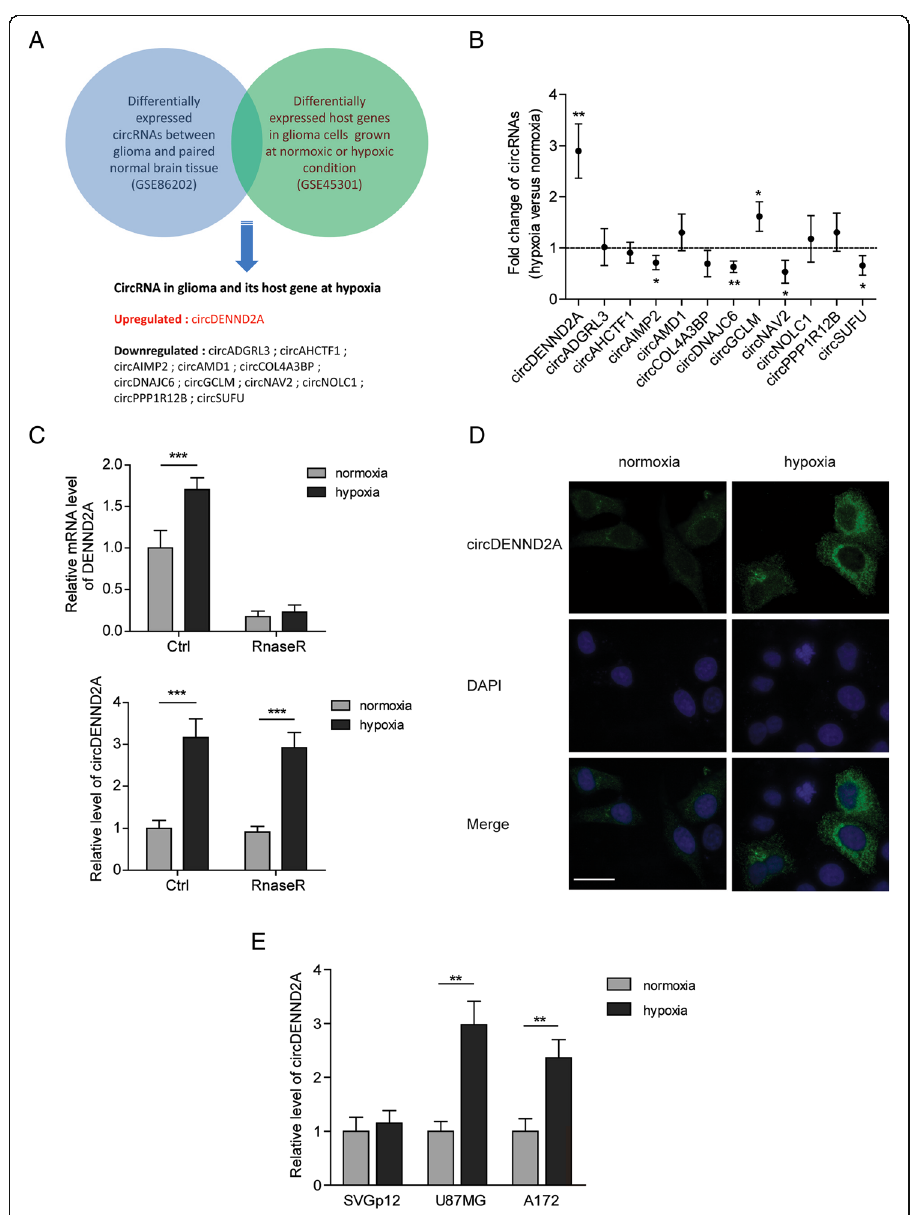
Fig. 1 CircCENND2A is a hypoxia-responsive circRNA in glioma cells. a Hypoxia-associated circRNAs in glioma were screened by comparing the differentially expressed circRNA profiles between glioma and normal tissues (GSE86202) and by comparing the differentially expressed mRNA profiles in U87MG cells between hypoxia and normoxia (GSE45301). b Fold changes of the screened circRNAs under hypoxia versus normoxia were measured by qPCR in U87MG cells. c The levels of DENND2A mRNA or circRNA in normoxic or hypoxic U87MG cells treated with or without RNase R were measured by qPCR. d RNA fluorescence in situ hybridization showed the abundance and localization of circDENND2A in normoxic or hypoxic U87MG cells. DAPI solution was used to stain the nuclei. e The levels of DENND2A circRNA in normoxic or hypoxic SVGp12, U87MG, and A172 cells were measured by qPCR. Data are shown as mean ± SD (three independent repeats). * p < 0.05, ** p < 0.01, *** p <